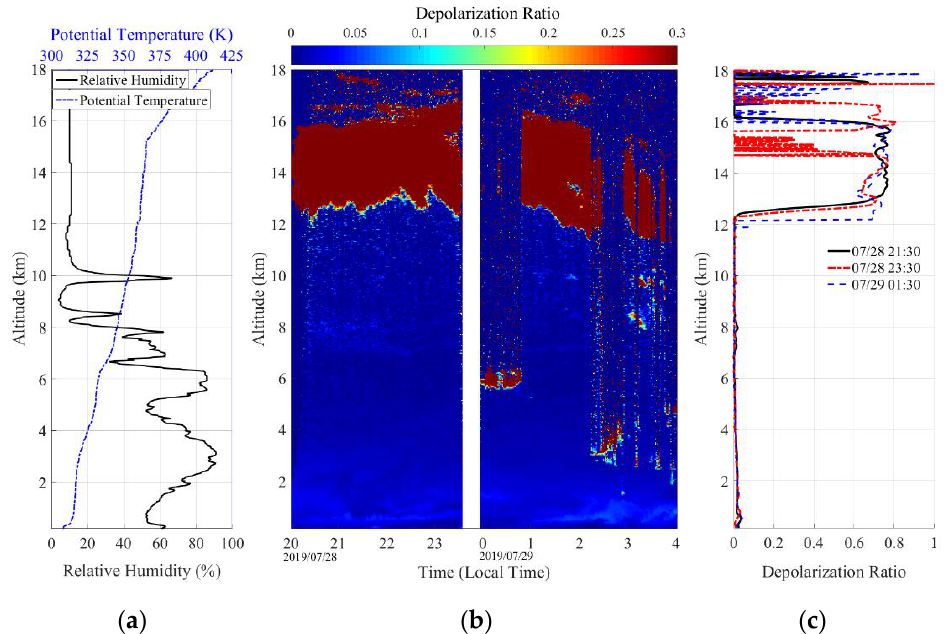
Figure 10. ( a ) The RH and PT profiles of GTS1 Digital Radiosonde at 19:15 on 28 June 2019; ( b ) THI of DR from 20:00 on 28 July to 4:00 on 19 July 2019; ( c ) Profiles of DR at different times.